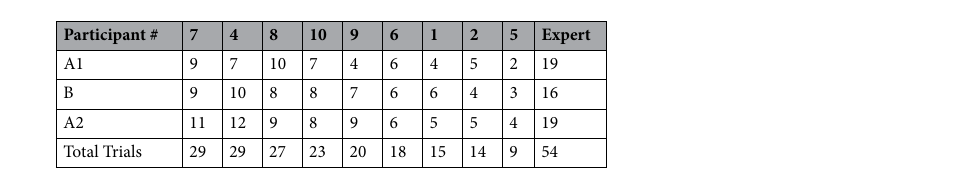
Table 1. Number of completed trials at each condition. Participants are sorted based on the total performed